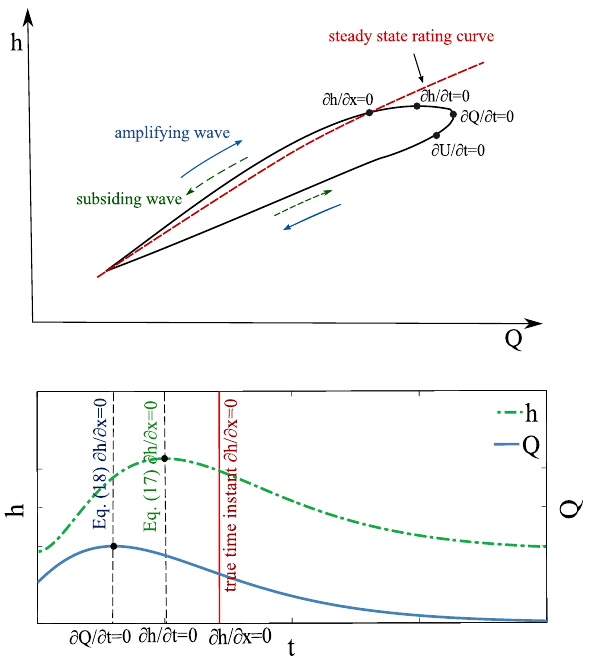
Figure 6. Comparison between rating curve for flood wave and steady flow with characteristic points, based on Henderson (1963) (upper panel), and impact of kinematic wave approximation (Eqs. 17, 18) on the assessment of time instant at which ∂h (lower